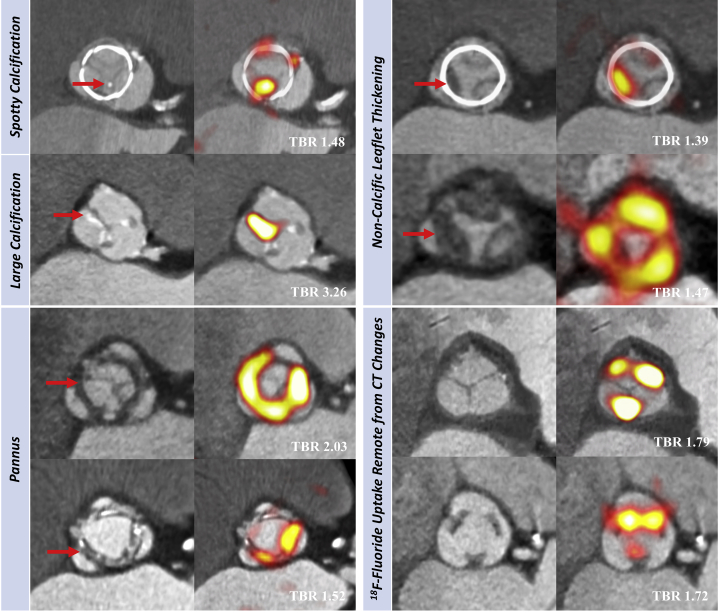
In Vivo 18F-fluoride PET and CT Imaging of Patients With Bioprosthetic Aortic ValvesBaseline CT (left) and 18F-fluoride PET (right) images from patients with bioprosthetic aortic valves. En face CT images of aortic bioprosthetic valves showing spotty calcification and large calcification (top left), circumferential pannus (bottom left), and noncalcific leaflet thickening suggestive of thrombus (top right) (all abnormalities identified by red arrows). Hybrid en face PET-CT images in the same patients: increased bioprosthetic 18F-fluoride activity (red/yellow areas) is observed in each patient colocalizing with the CT abnormalities. 18F-fluoride activity was also commonly observed remote from leaflet changes on CT (bottom right). Target-to-background (TBR) values are annotated on the hybrid PET-CT images in white text. Abbreviations as in Figure 1.